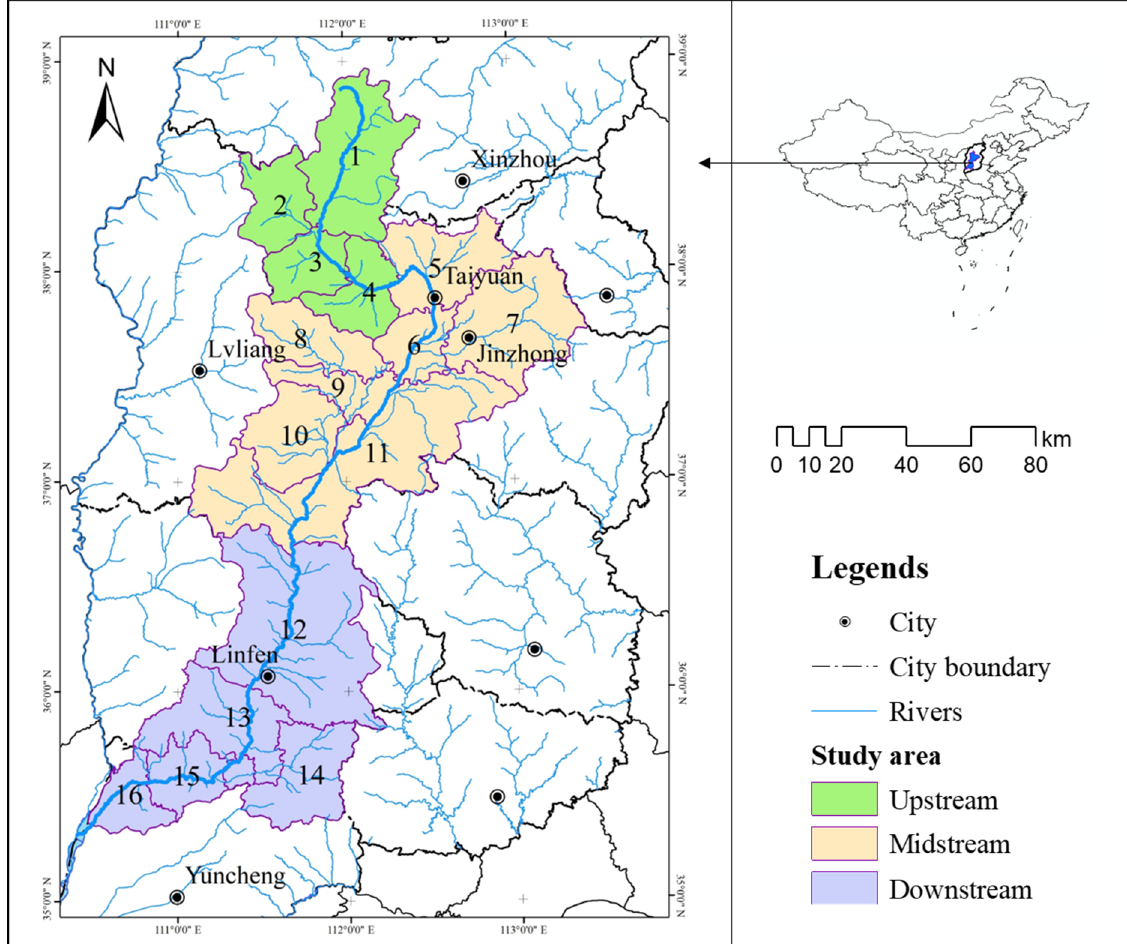
Figure 2. Geographical position and study area of the Fenhe River Basin.